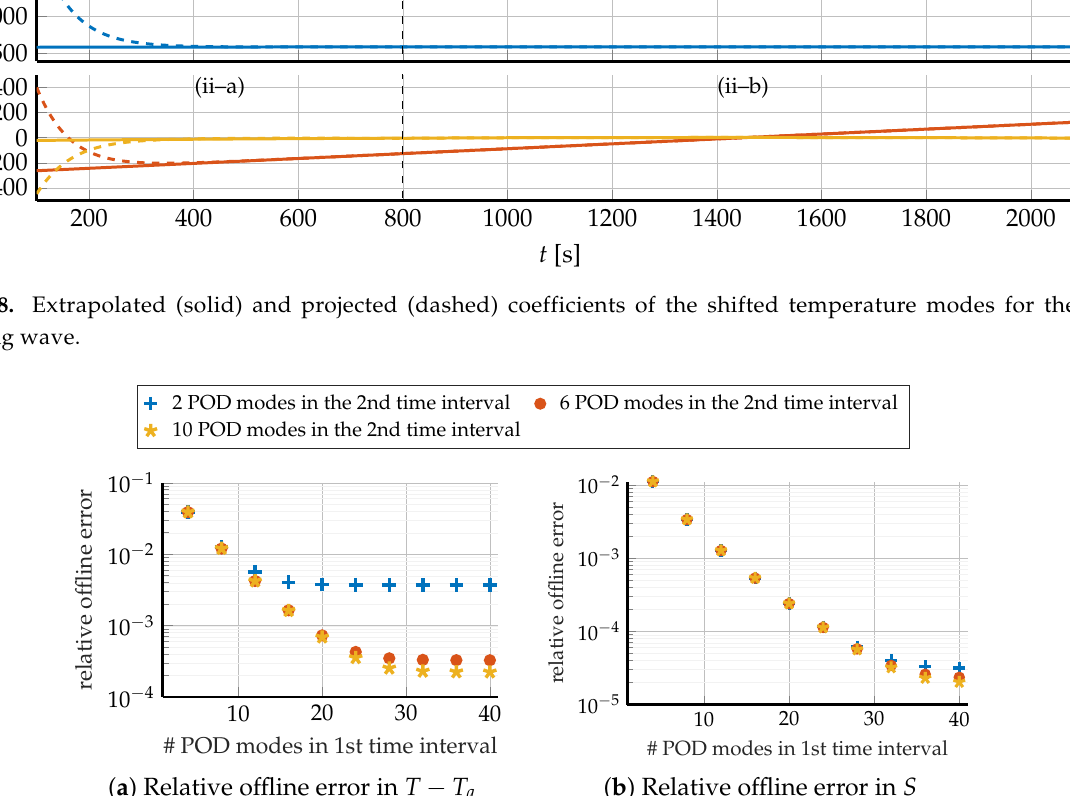
( b ) Relative offline error in S Figure 9. Relative offline errors for different POD mode numbers in the first and in the second time interval. Figure 9. Relative offline errors for different POD mode numbers in the first and in the second time interval. Figure 9. Relative offline errors for different POD mode numbers in the first and in the second time interval. Figure 9. Relative offline errors for different POD mode numbers in the first and in the second time interval. Figure 9. Relative offline errors for different POD mode numbers in the first and in the second time